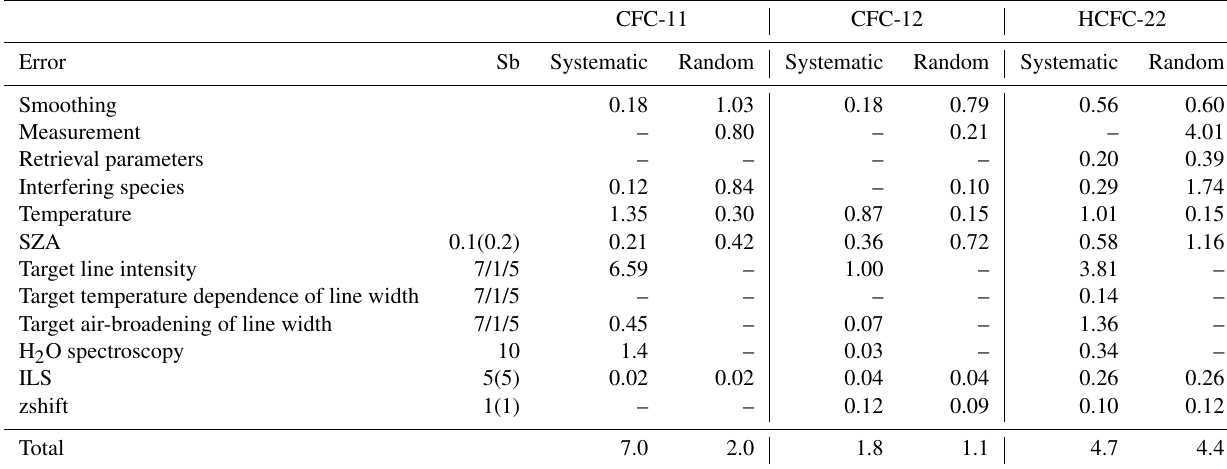
Table 2. Systematic and random uncertainties (in %) for CFC-11, CFC-12 and HCFC-22 at St Denis. Sb represents the relative uncertainties (absolute value) of the non-retrieved parameters (also in %), and the detail information about the sb value of each parameter is described in the text. For SZA, ILS and zshift, both the systematic uncertainty and the random uncertainty (in the bracket) are listed here. When a relative uncertainty is smaller than 0.01%, it is considered negligible and represented as “–”. CFC-11 CFC-12 HCFC-22 Error Sb Systematic Random Systematic Random Systematic Random Smoothing 0.18 1.03 0.60 Measurement – Retrieval parameters – Interfering species Temperature SZA Target line intensity 7/1/5 Target temperature dependence of line width Target air-broadening of line width H 2 O